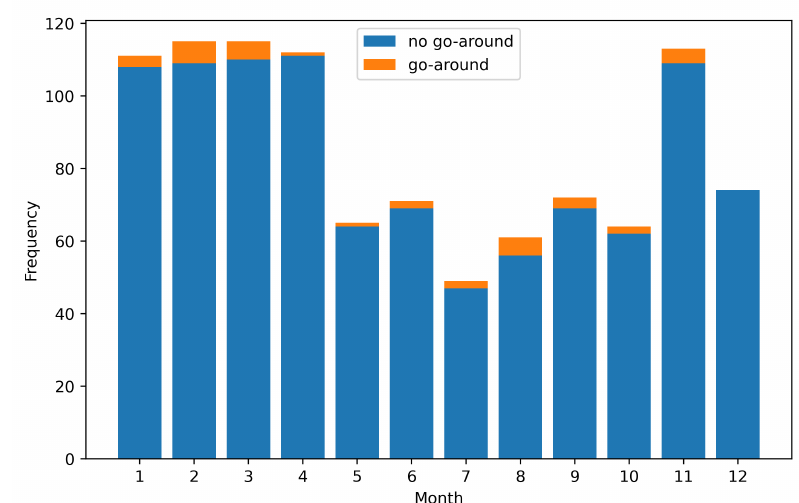
Figure 2. Distribution of flights over the year 2019, comparison of flights with go-around (total 34) and without (total 988).